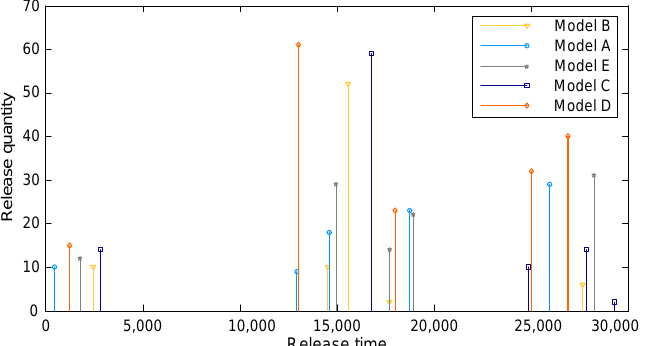
Figure 5. Order releasing and multi-item scheduling in the rolling three day planning horizon.